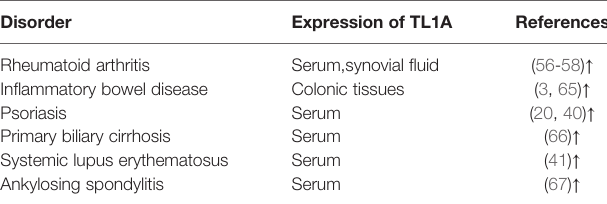
TABLE 1 | Expression of TL1A in in fl ammatory autoimmune diseases.